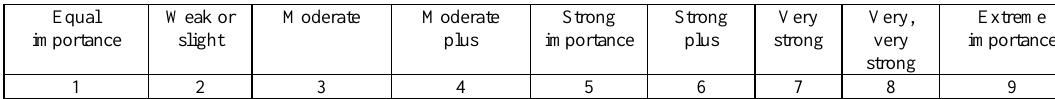
Table 1. Scaling: (as per Satty